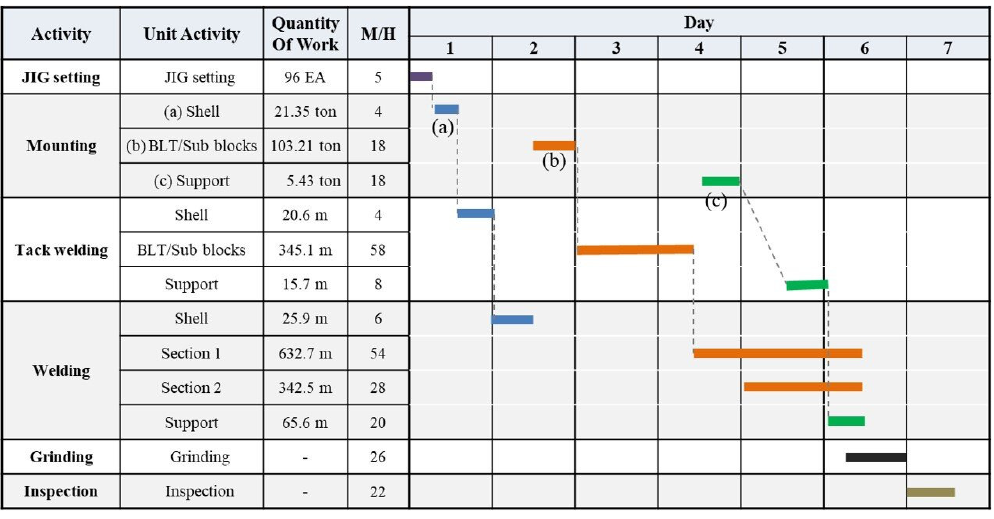
Figure 2. Example of a curved block assembly